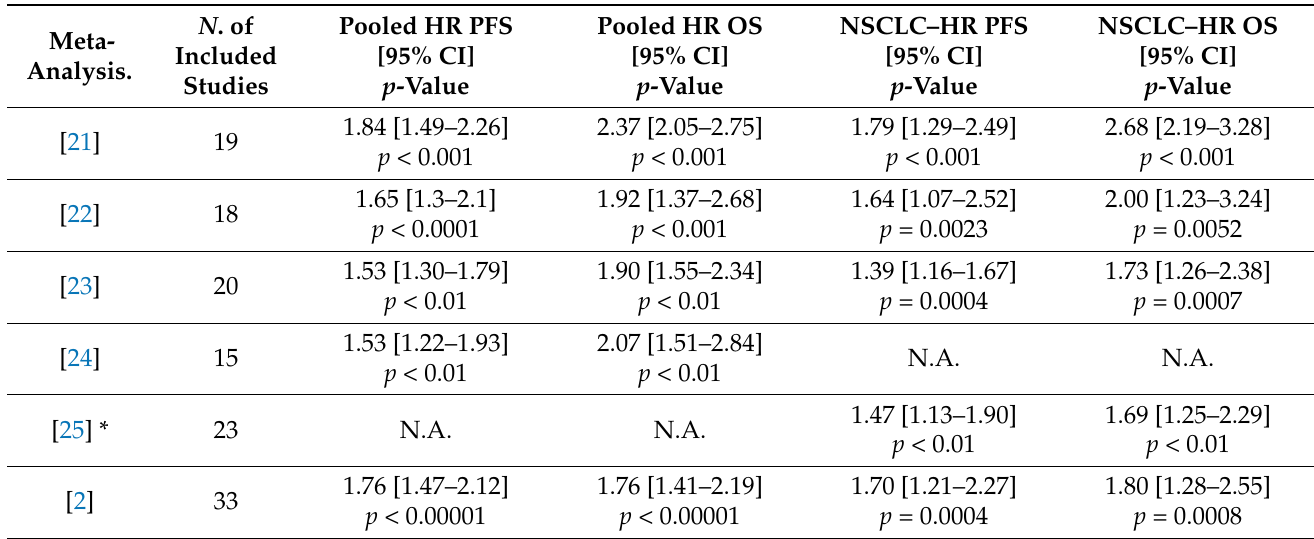
Table 1. Meta-analyses evaluating the impact of antibiotics administration on clinical outcomes of advanced cancer patients treated with immune-checkpoint inhibitors, focusing on results obtained in non-small-cell lung cancer. Meta-